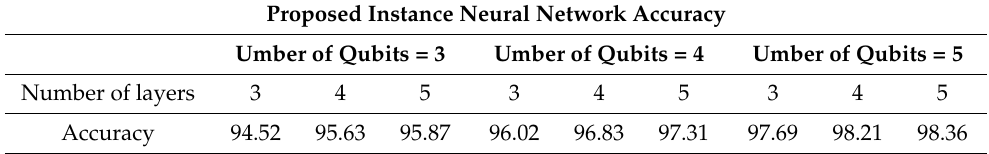
Table 7. K-fold Cross Validation.